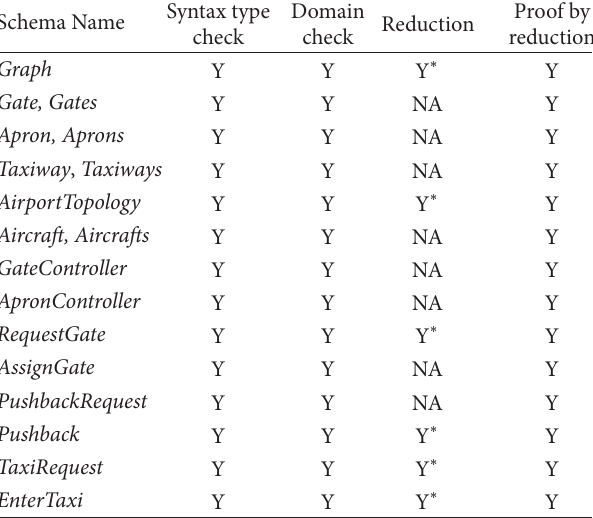
Table 1: Results of model